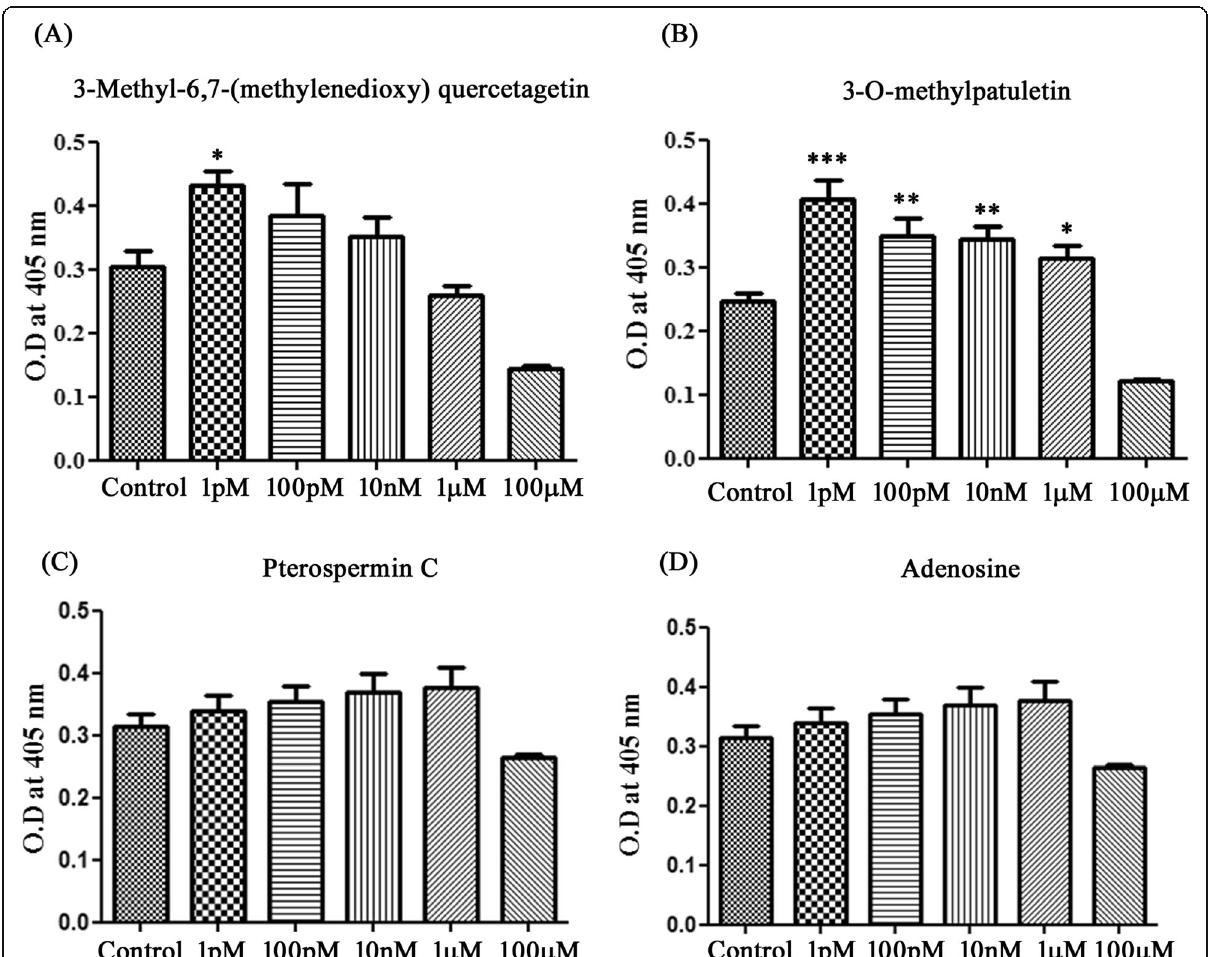
Fig. 4 Alkaline phosphatase (ALP) activity in calvarial osteoblast cells of isolated compounds from the extract. a 3-Methyl-6,7-(methylenedioxy) quercetagetin (K007) ( b ) 3-O-methylpatuletin (K008) ( c ) Pterospermin C (k009) ( d ) Adenosine (K010). Data shows Mean ± S.E.M of three independent experiments ***p < 0.001; **p < 0.01 and *p < 0.05 as compared with untreated cells taken as